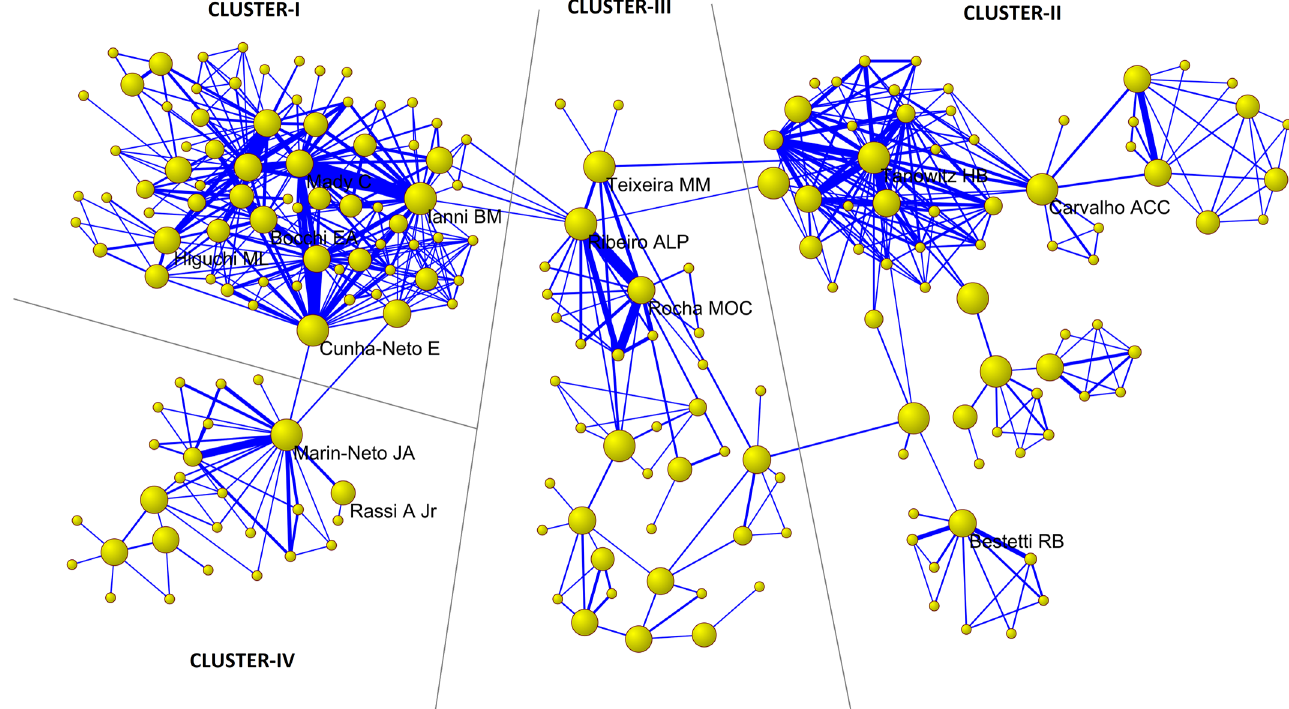
Fig 3. Main research foci of the co-authorship network, generated from the documents on Chagas cardiomyopathy indexed in MEDLINE.